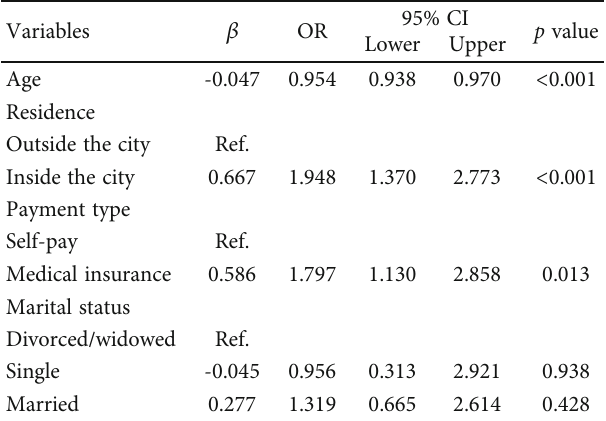
Table 3: The ordinal logistic regression of factors associated with the times of hospitalizations.